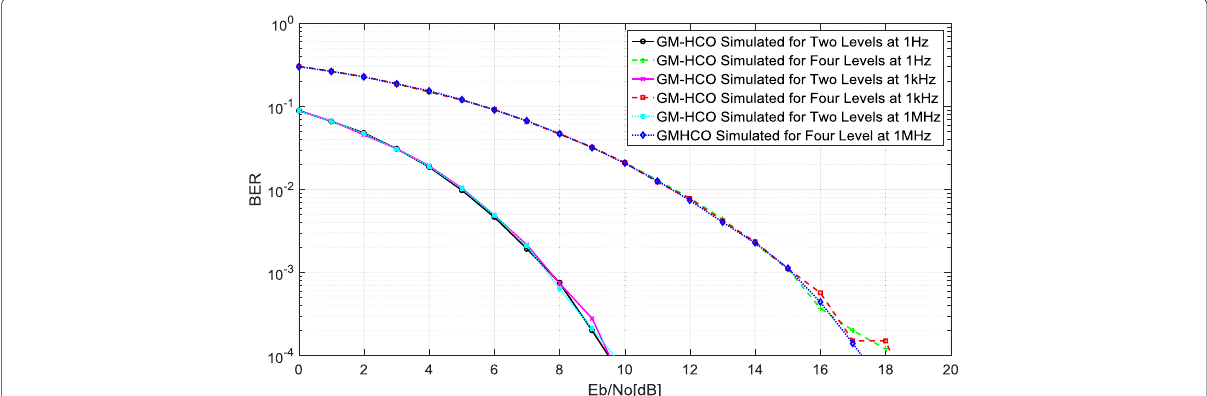
Fig. 15 BER performance of the proposed hybrid chaotic system over AWGN channel with variable